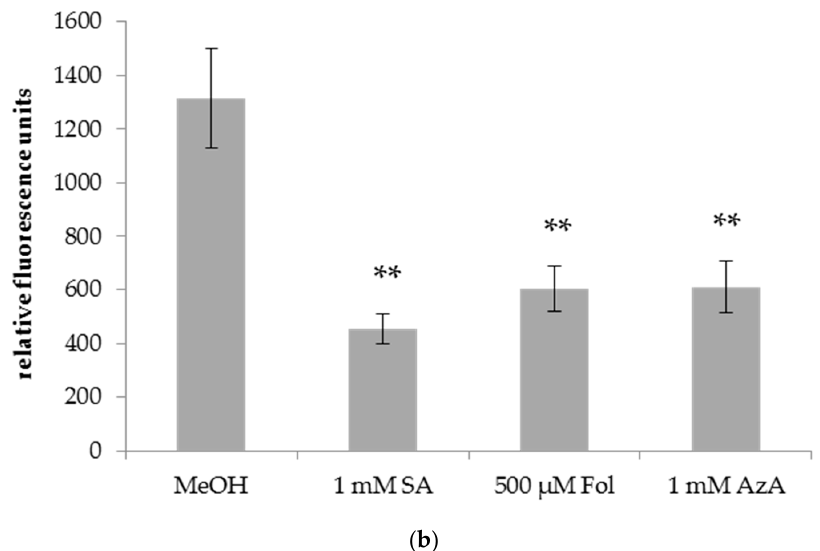
Figure 4. Relative fluorescence of DAF-FM DA staining of Bgh in leaves of barley plants after application of SA, Fol, or AzA to leaf 1. Barley cultivar GP plants were infiltrated in the first true leaf with 0.025% MeOH as control, 1 mM SA, 500 µM Fol, or 1 mM AzA in 10 mM MgCl 2 as indicated below the panel. Five days later, the plants were infected with Bgh spores. Leaf discs were cut out of the first (local) ( a ) and second (systemic) ( b ) true leaf and stained with DAF-FM DA. Fluorescence was recorded using a spinning disc (confocal) microscope. Bars represent the average of 37–64 replicates from 2 (SA treatment in b ) to 3 (all other treatments) independent experiments ± standard error; replicates were as follows: ( a ) MeOH: 57 (22 + 14 + 21), SA: 62 (22 + 16 + 24), Fol: 55 (19 + 19 + 17), AzA: 58 (19 + 18 + 21); ( b ) MeOH: 55 (20 + 22 + 13), SA: 37 (17 + 20), Fol: 64 (21 + 23 + 20), AzA: 53 (6 + 24 + 23). Asterisks above the bars indicate statistically significant differences from the mock control treatment (one-way ANOVA and poct hoc Dunnett’s test, ** p < 0.005).